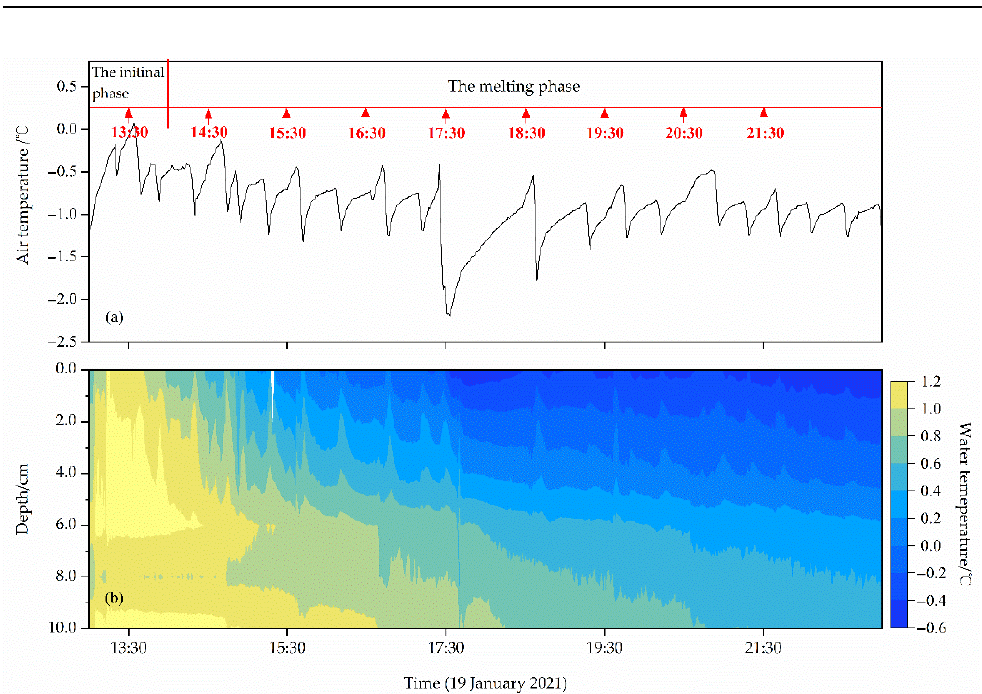
Figure 4. The ( a ) air and ( b ) water temperature variation processes of the tested samples of sea ice at a designed preliminary water temperature of 1.0 °C.